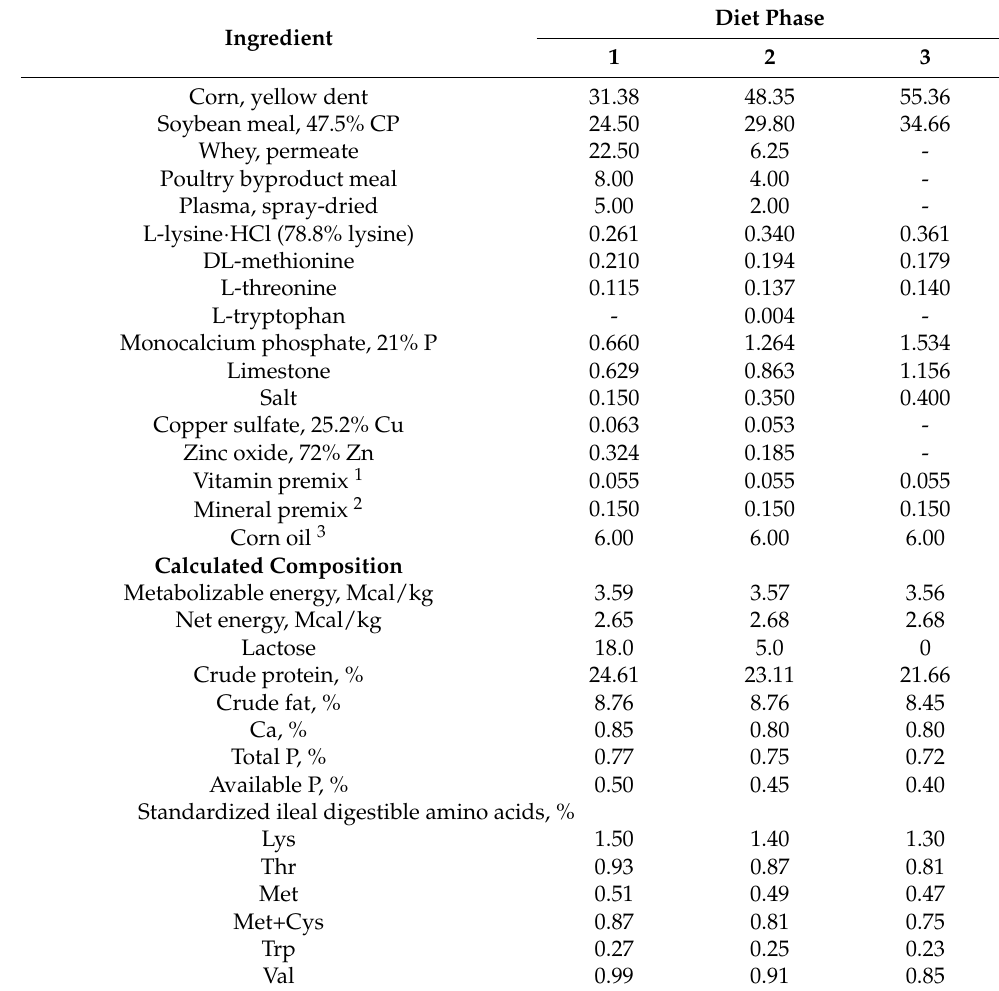
Table 1. Composition of experimental control diets fed during nursery phase 1 (day 0 to 14), 2 (day 14 to 25), and 3 (day 25 to